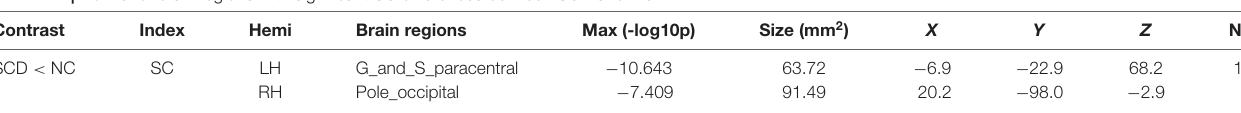
TABLE 2 | Full list of brain regions with significant SC differences between SCD and NC.